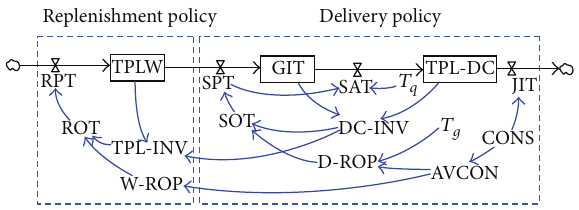
Figure 11: TPL replenishment and delivery subsystem causality diagram.